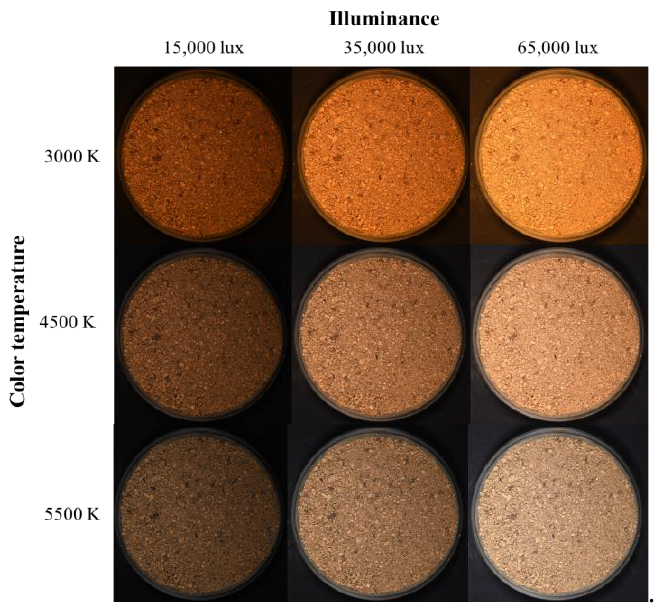
Figure 6. Digital images of Gwanak soil. The color temperature is a numerical representation of the chromaticity of the light source using absolute temperature (K). The color temperature of a red light source is lower, and the color temperature of a blue light source is higher. The illuminance of the